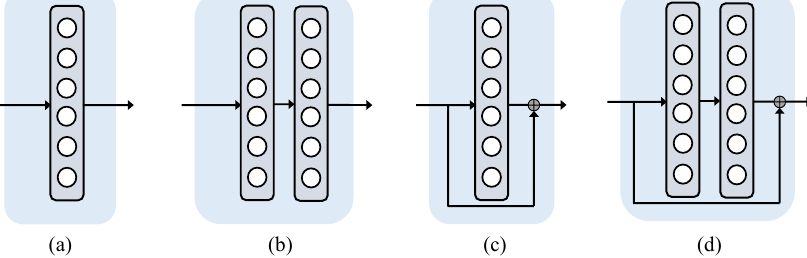
Figure 2. Architecture of the projection grouping module. The projection grouping network adopts a residual structure [46] consisting of a fully connected network based feedforward path and a shortcut connection (see case ( c ) and case ( d )). Compared with case ( c ), case ( d ) utilizes a fully connected two-layer feedforward network. The projection grouping layer takes merged heatmaps with a shape of [ w , h ,8 ] as input and generates the same sized heatmaps containing only one peak in each channel. On the input side, merged heatmaps with a shape of [ w , h ,8 ] are flattened to match the architecture of projection grouping module. On the output side, the immediate output is reshaped to generate filtered projection heatmaps. All layers have rectified linear unit (ReLU) [47] activation function except for the output layer. Dropout layers [48] are employed for the first dense layer, and the softmax function are placed after the add operation. Different configurations of projection grouping layer are detailed in the evaluation section. Additional case ( a ) and case ( b ) are plain module without shortcut connection, which are tested for comparison